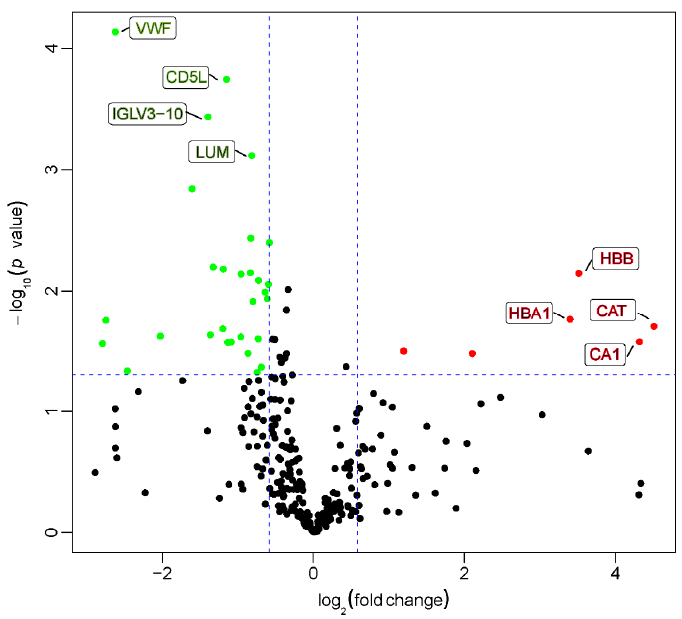
Figure 1. Volcano plot of all proteins. Red dots represent proteins with a significant fold change (FC) ≥ 1.5 ( p < 0.05); green dots, proteins with a significant FC ≤ 0.667 ( p < 0.05); black dots, no obvious changes in the protein level. Table 2. Thirty-five differentially expressed proteins between the experimental and control groups.